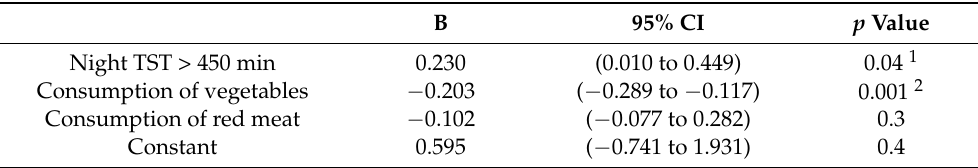
Table 5. Associations of TNF- α with modifiable lifestyle habits using Multiple Linear Regression analysis in the entire sample.